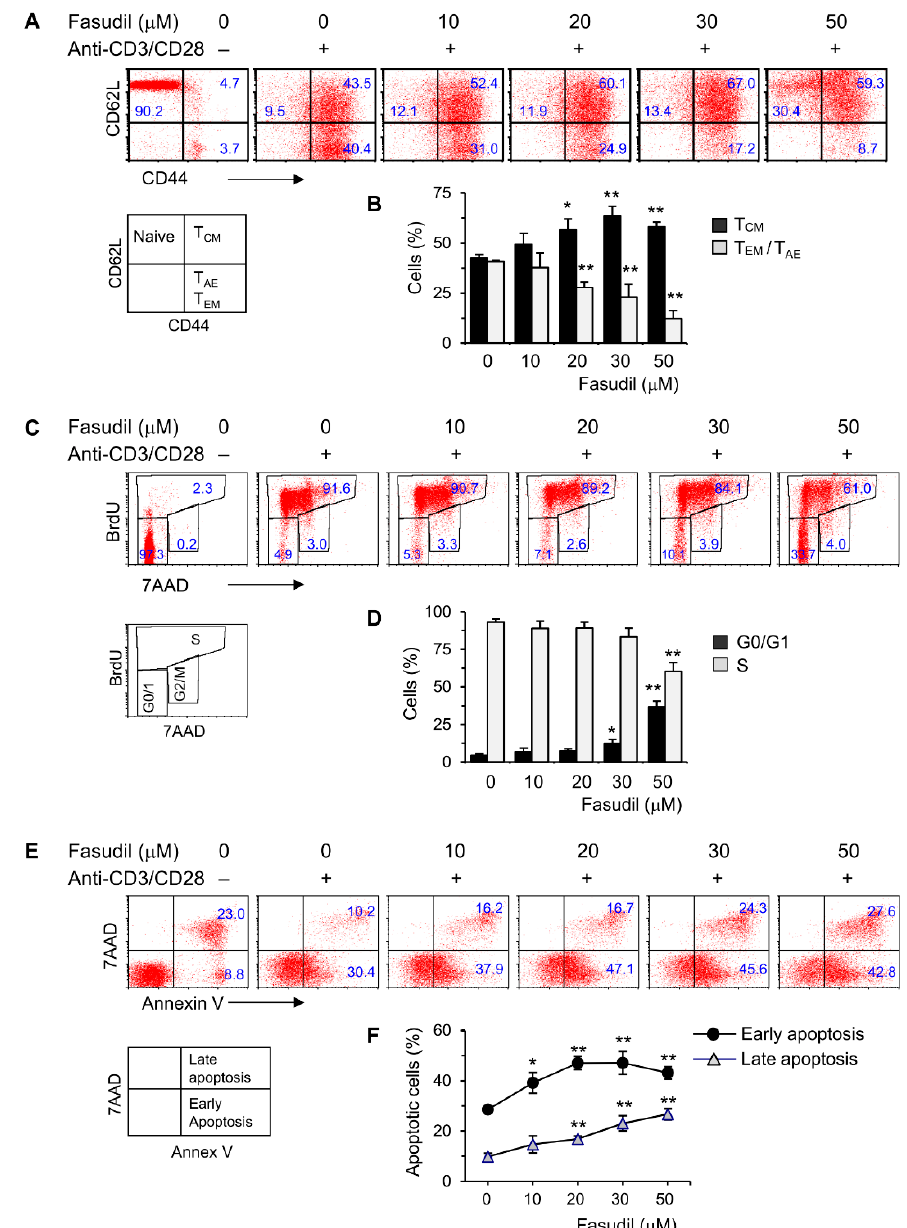
Figure 2. Fasudil inhibits T cell activation and proliferation and induces apoptosis in vitro. Naïve CD4 + T cells pooled from six mice were stimulated with plate-bound anti-CD3 plus free anti-CD28 for two days without or with fasudil (0–50 µM). Cells were collected and processed for FACS staining.